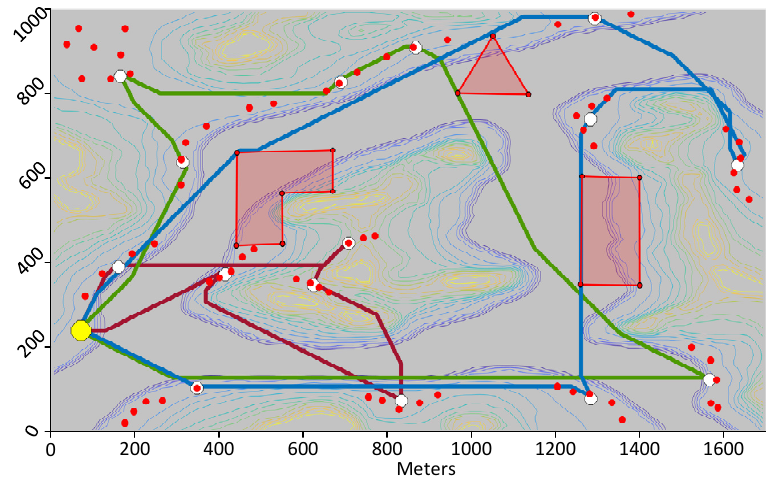
Figure 12. Path minimizing time for three UAVs visiting 15 download points covering the 70 sensors. Table 3. Statistics for the Paths Shown in Figure 12.